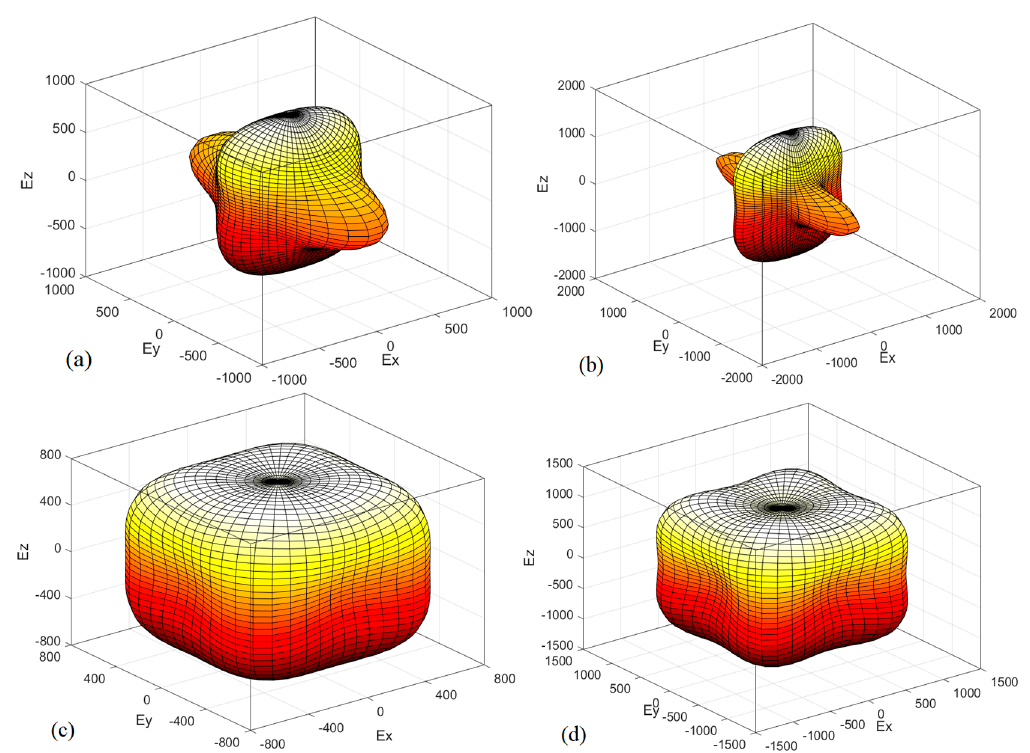
Figure 8. The directional dependence of Young’s modulus for: m -C 3 N 4 ( a , b ); and t -C 3 N 4 ( c , d ).